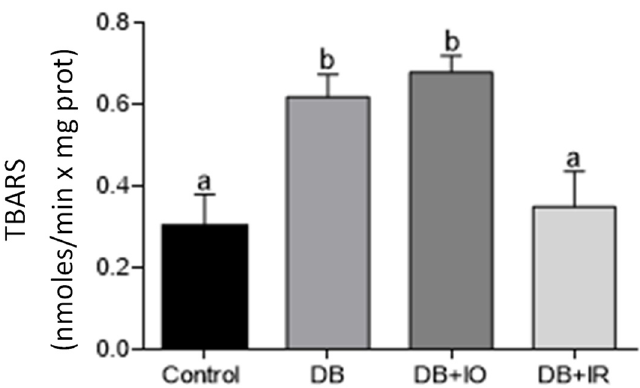
Figure 6. Effects of iron on muscle lipid peroxidation. Data are presented as group mean ± standard error. p < 0.05 ( n = 6, ANOVA plus Tukey’s post hoc test). Different letters indicate statistically significant differences. DB + IO, diabetic rats with iron overload; DB + IR, diabetic rats with iron restriction diet.